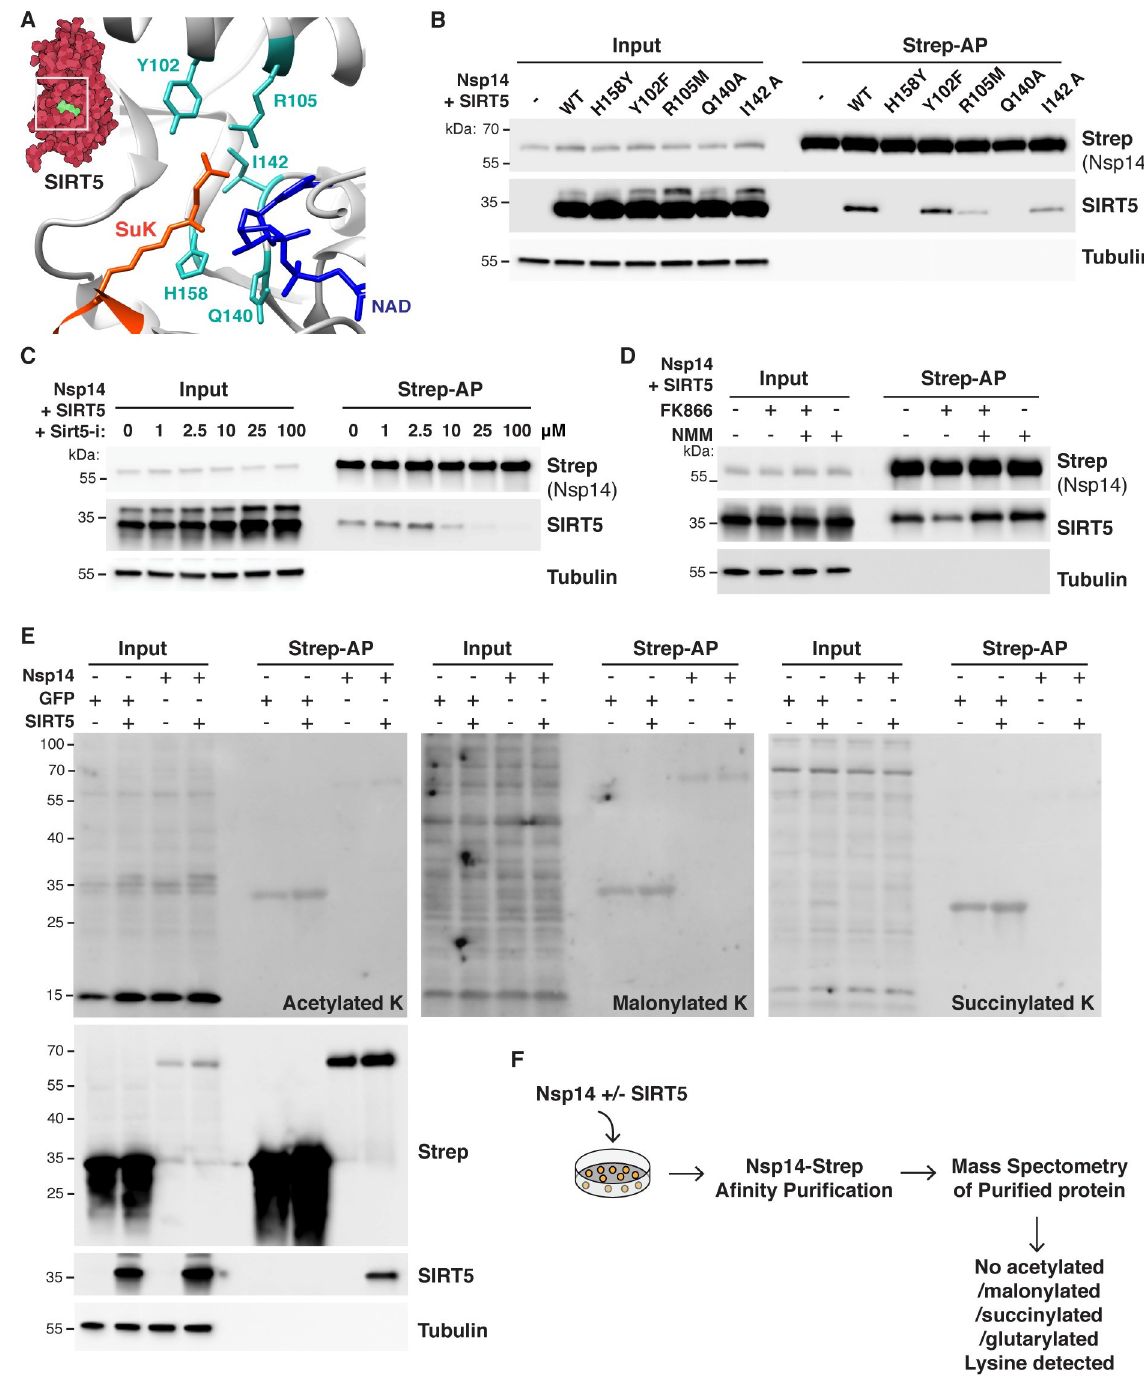
Fig 2. SIRT5 catalytic activity is necessary to interact with Nsp14. A . Cartoon representation of the protein structure of SIRT5 catalytic site in complex with cofactor NAD and succinylated lysine substrate (SuK), showing conserved residues mutated in panel B. B . Strep-tag affinity- purification and western blot after transfection of Sirt5- KD HEK293T cells with Nsp14-strep and SIRT5 catalytic mutants, showing that the interaction with Nsp14 is lost in several mutants. C . Strep-tag affinity-purification and western blot after transfection with Nsp14-strep and SIRT5, in SIRT5- KD HEK293T cells incubated with increasing concentrations of SIRT5 inhibitor Sirt5-i. High concentrations of Sirt5-i prevent the interaction. D . Strep-tag affinity-purification and western blot after transfection with Nsp14-strep and SIRT5, in SIRT5- KD HEK293T cells incubated with NAMPT FK866 inhibitor (low cellular NAD), FK866 and NMN, or NMN alone (high cellular NAD). SIRT5 binding strength correlated with NAD levels. E . Pan-acetylation, malonylation and succinylation in SIRT5- KD HEK293T total or Strep-purified proteins,